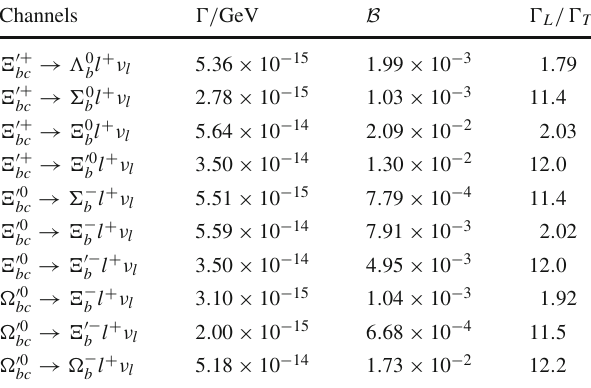
Table 19 The bc sector with the c quark decay and a scalar bc diquark in the initial state: decay widths, branching ratios and the (cid:14) L /(cid:14) T for semileptonic decays, with lepton mass neglected. We have assumed m